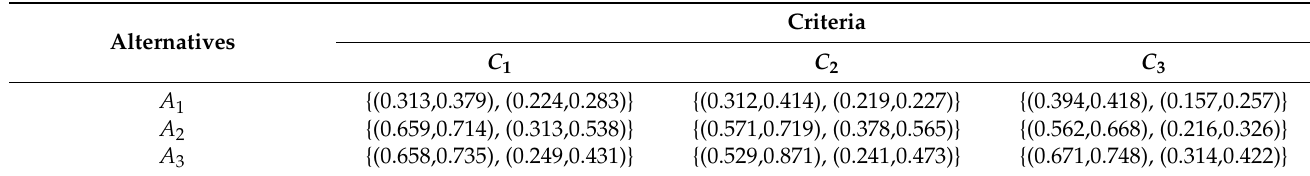
Table 2. The aggregated interval-valued intuitionistic fuzzy decision